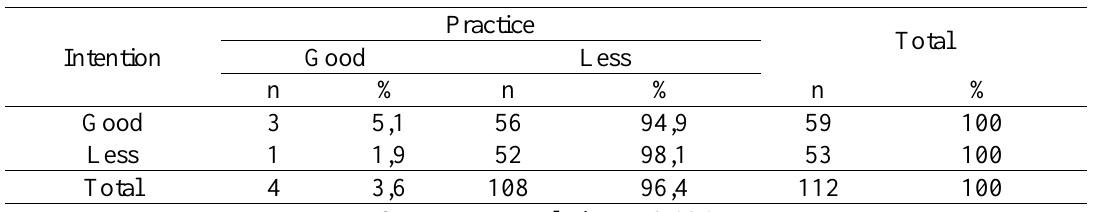
Table 5. Cross Tabulation between intention and practice In Implementation of Diabetes Mellitus Education Based on Theory of Planned Behavior in Public health center around Surabaya in 2016